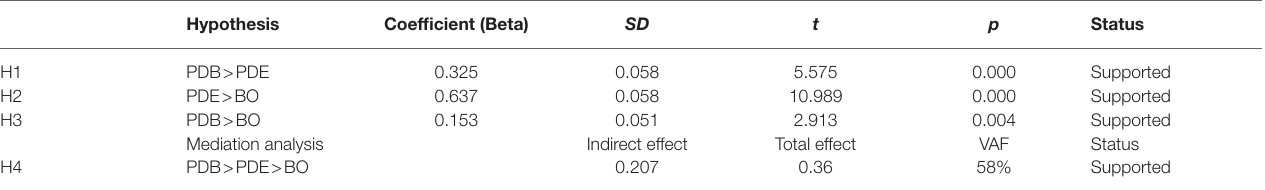
TABLE 5 | Hypotheses